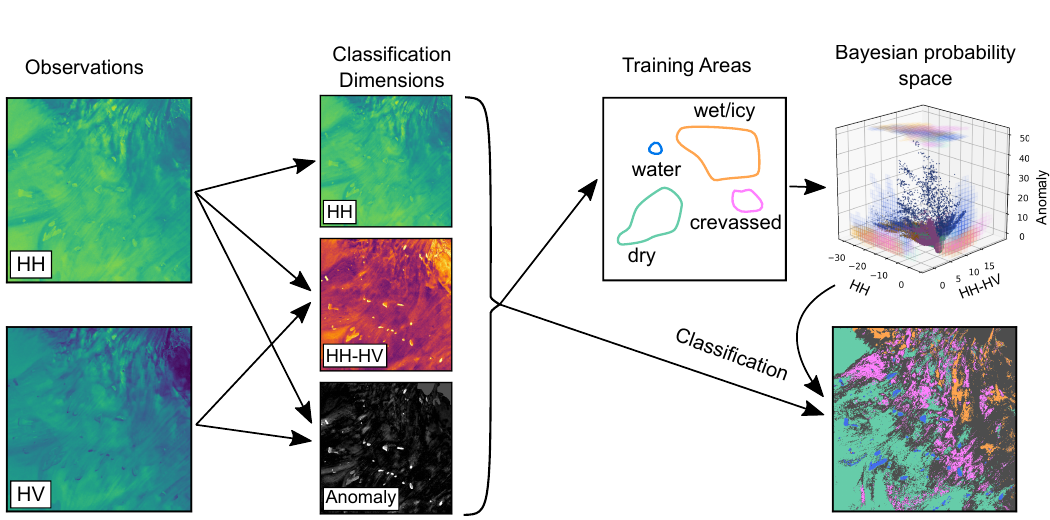
Figure 2. Flowchart of our PBC approach. The three largely independent classification dimensions are derived from the two observables. Selected training polygons define representative spectral signatures of each class, which are used to create a probability space. With the help of this Bayesian probability space, we obtain the likelihood that a pixel belongs to a specific class and classify the